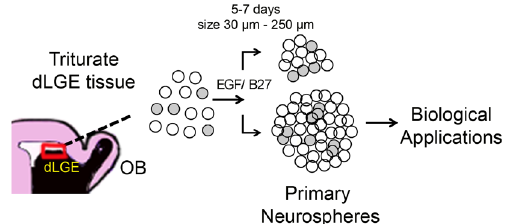
and B27. After 7 days in vitro neurospheres are on average between 50 μm to 100 μm in size. Neurospheres generated can be used for various downstream